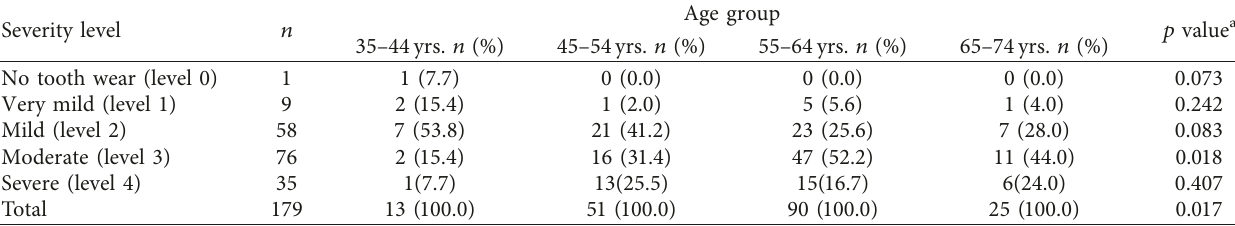
Table 3: Severity of different types of tooth wear according to age group ( n � 179).